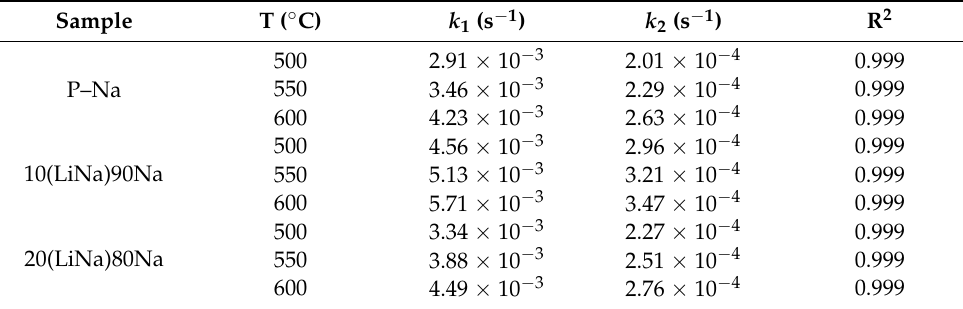
Table 2. Kinetic parameters of P–Na, 10(LiNa)90Na, and 20(LiNa)80Na at 500–600 ◦